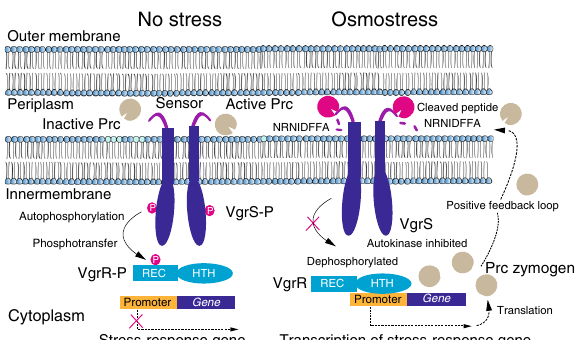
Fig. 9 A model for VgrS proteolysis-triggered bacterial stress responses. When bacteria grow under osmostress, Prc is activated and then cleaves the N-terminal peptide (NRNIDFFA) of the sensor region of VgrS to inhibit the latter ’ s autophosphorylation. Dephosphorylation of the VgrS – VgrR two- component signal transduction system regulates VgrR – promoter interactions and triggers the transcription of stress-response genes, which is required for X. campestris pv. campestris to resist osmostress. prc itself is controlled by VgrR, resulting in a positive feedback loop within